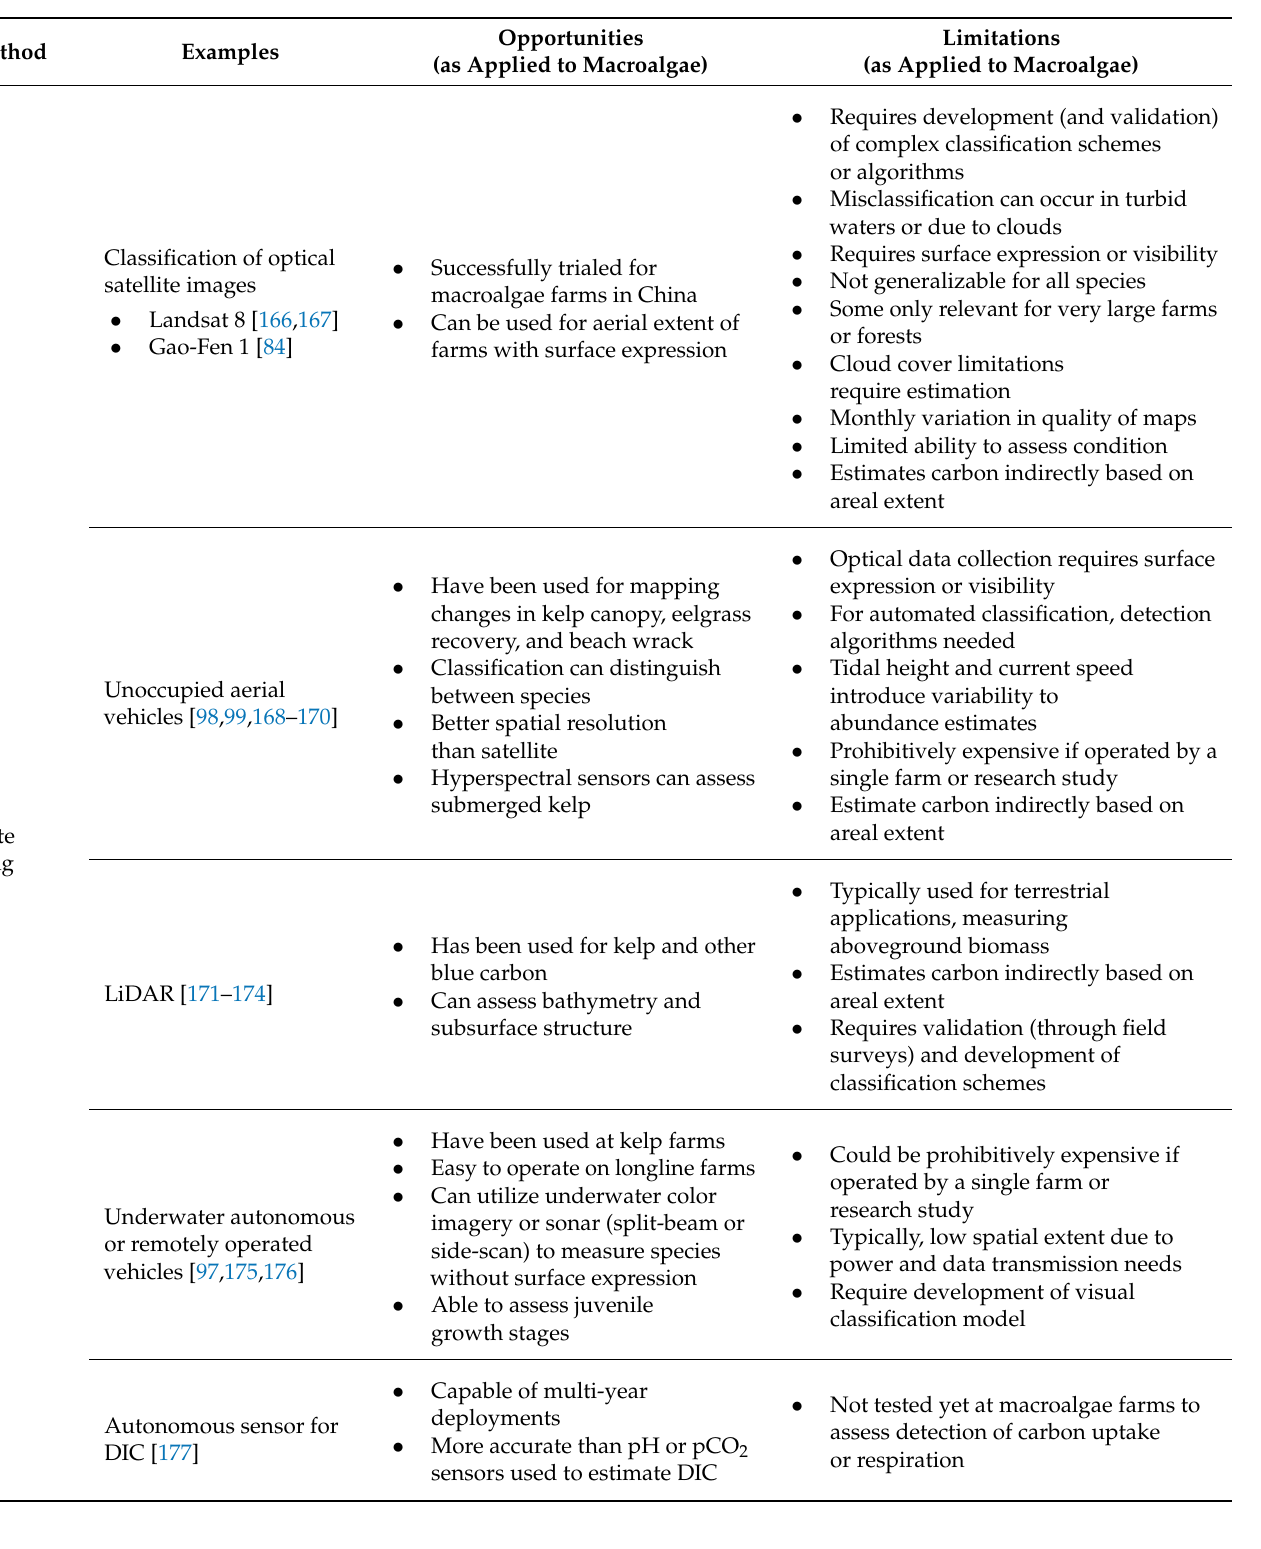
Table 2. Synthesis of opportunities and limitations of specific methods for monitoring carbon uptake and/or permanence in macroalgae, with